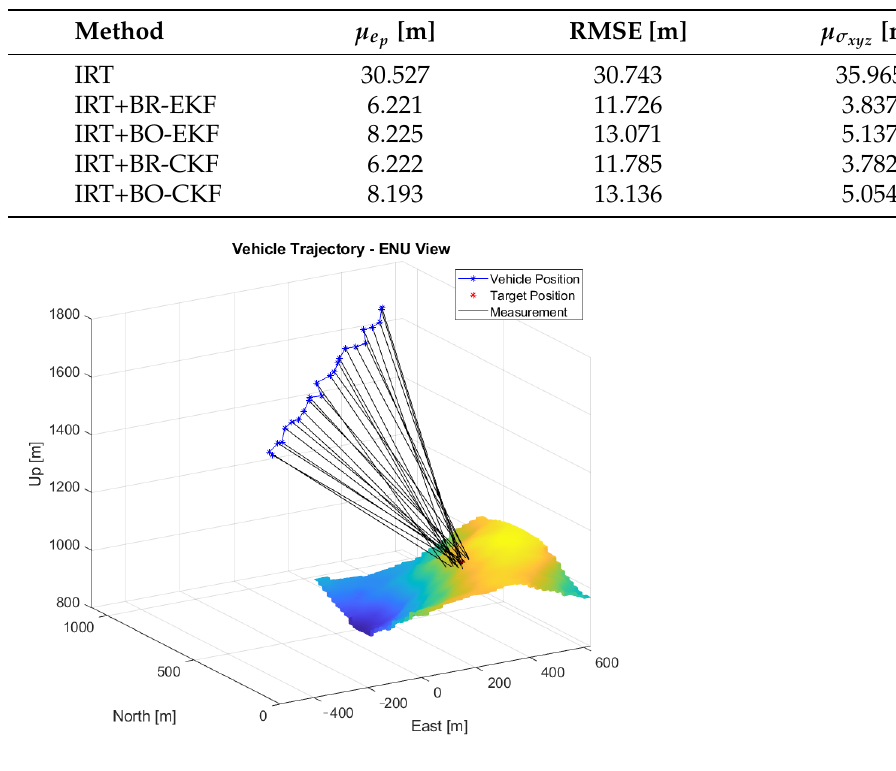
Table 4. IRT, IRT+BR-EKF, IRT+BO-EKF, IRT+BR-CKF and IRT+BO-CKF results for the rough terrain scenario.